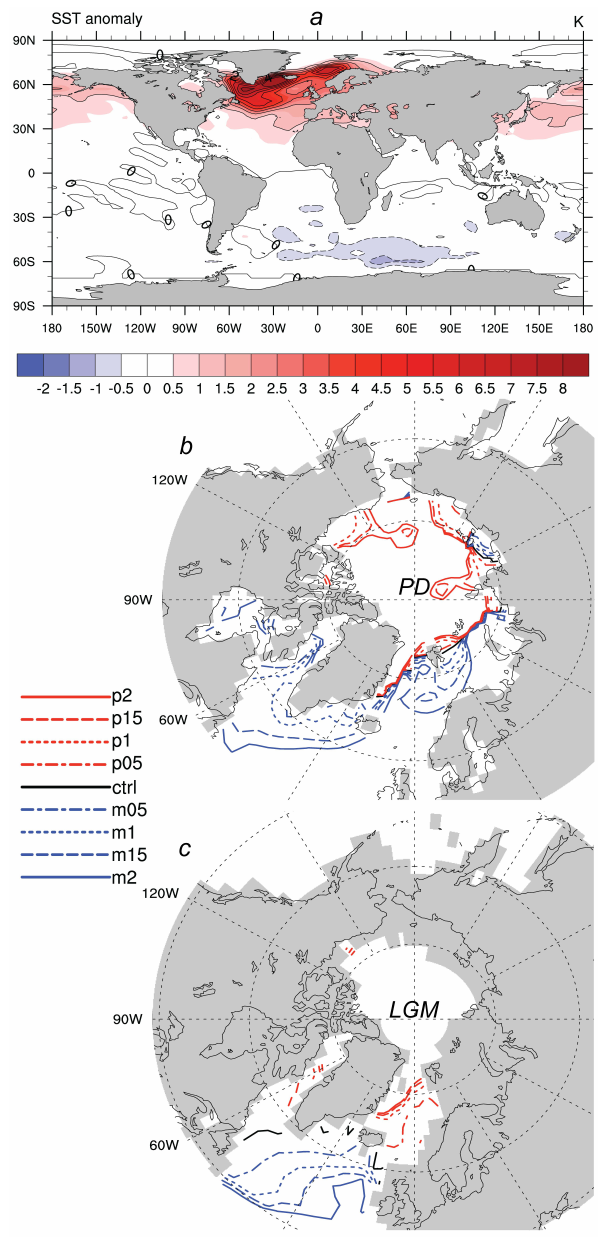
Fig. 1. (a) Annual sea surface temperature anomalies from ECBilt- CLIO experiments. Negative anomalies: dashed (0.5K intervals), positive anomalies: solid (1K intervals). Panels (b) and (c) : NH summer (JJA) sea ice lines ( − 1.8 ◦ C SST isotherms) for PD and LGM simulations,